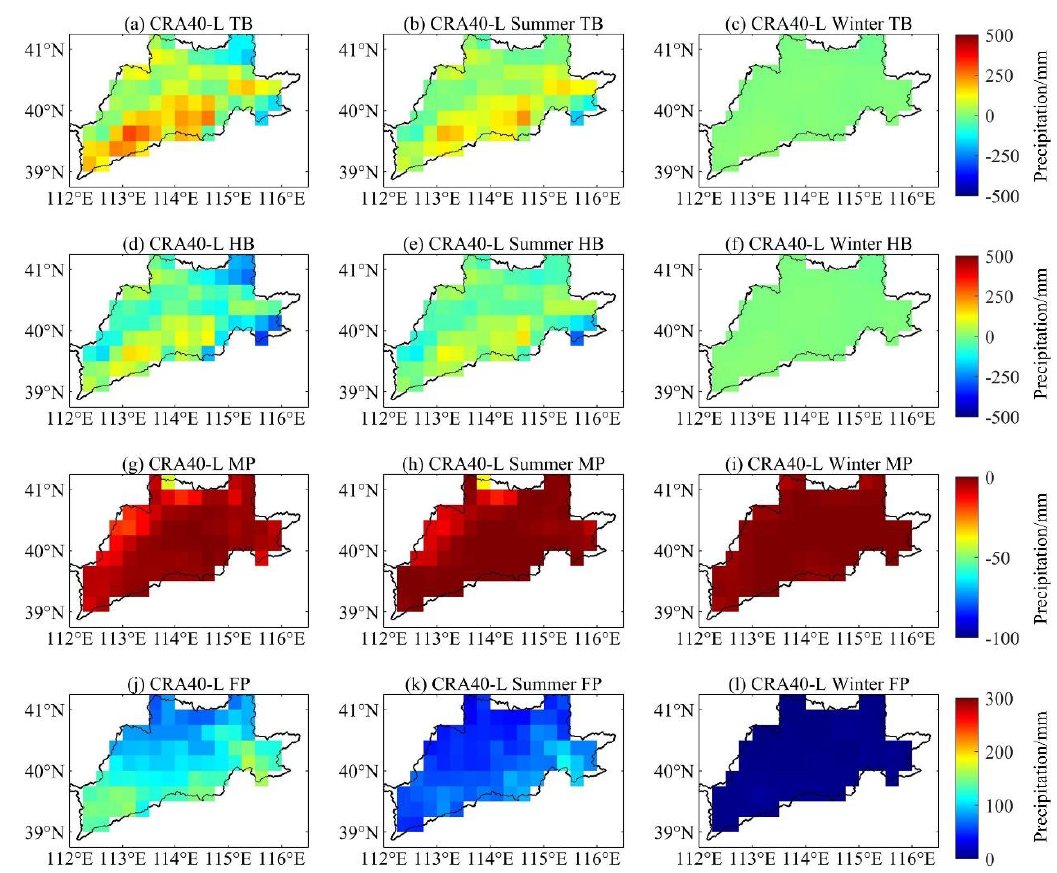
Figure 9. ( a – l) TB , HB , MP , and FP of CRA40-Land reanalysis precipitation data. Figure 9. ( a –l) TB , HB , MP , and FP of CRA40-Land reanalysis precipitation